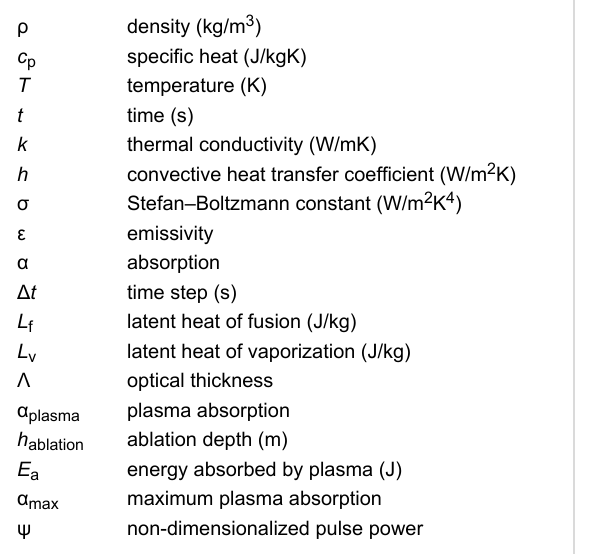
Table 4: Mathematical